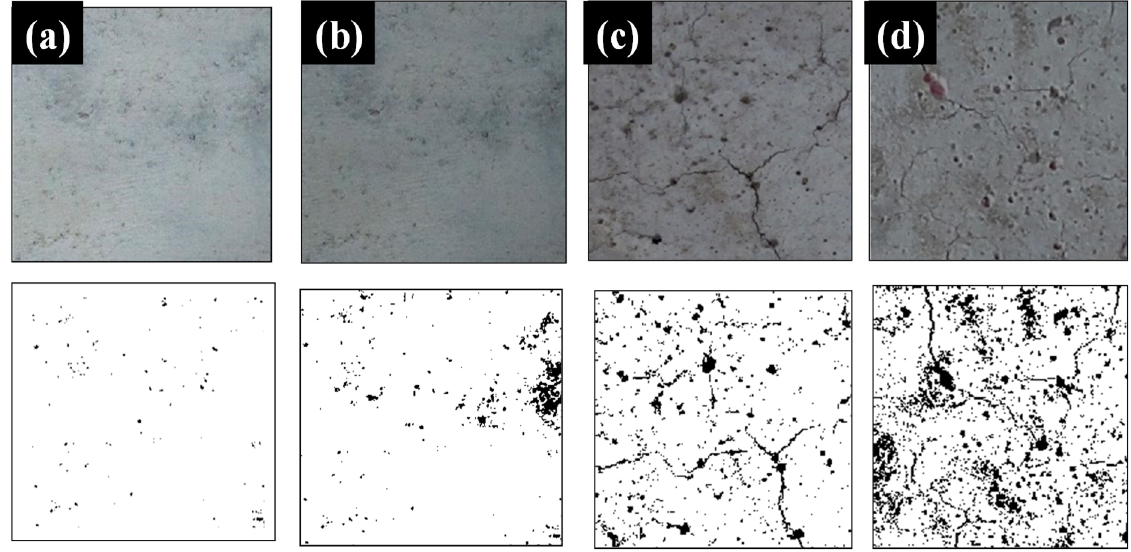
Figure 14. Image-based damage detection: ( a ) 30, ( b ) 60, ( c ) 90, ( d ) 120 min.